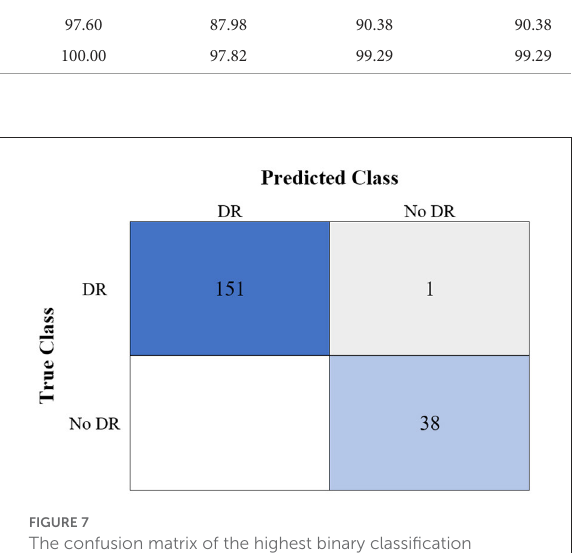
FIGURE7 The confusion matrix of the highest binary classification outcome for the GWO-ELM approach using the APTOS-2019 dataset.